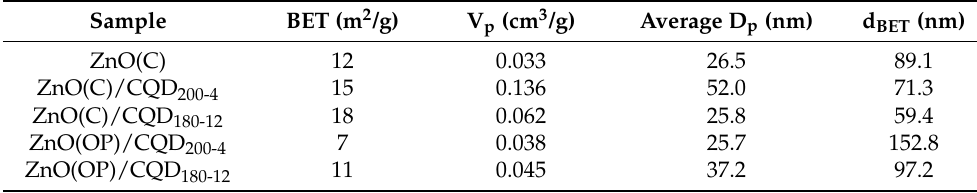
Table 3. BET analysis surface area and porosity of ZnO/CQD samples.